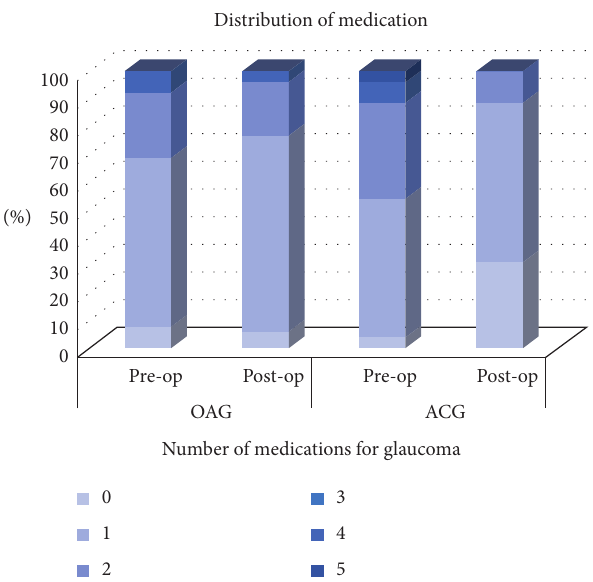
Figure 2: Distribution of medication in OAG and ACG before and after cataract